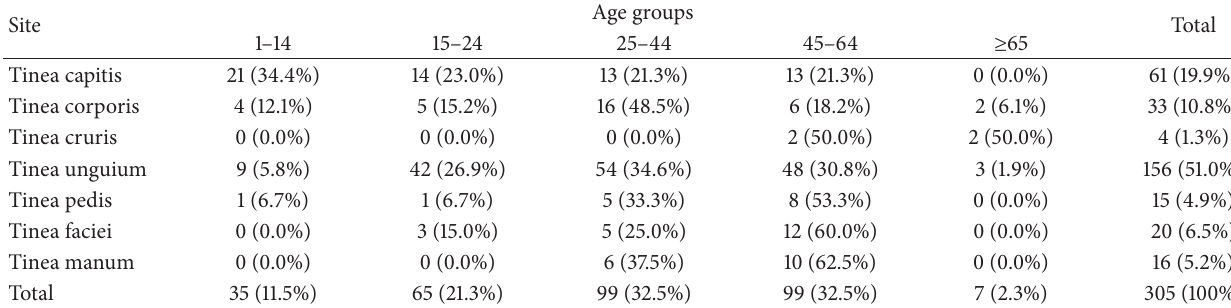
Table 2: Frequency of clinical manifestation in different age groups ( 𝑛 = 305).